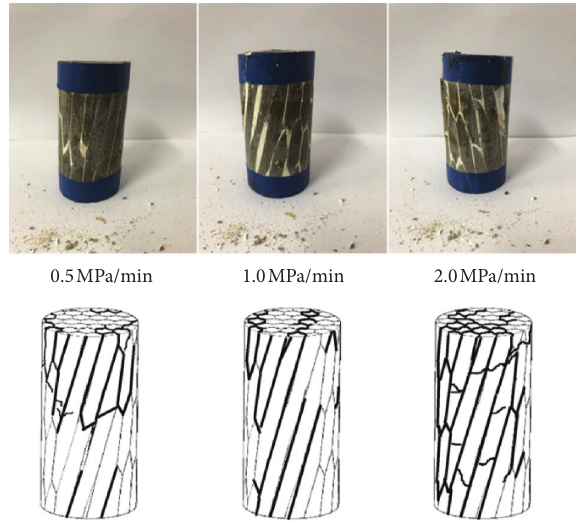
Figure 9: Failure modes at different unloading rates.